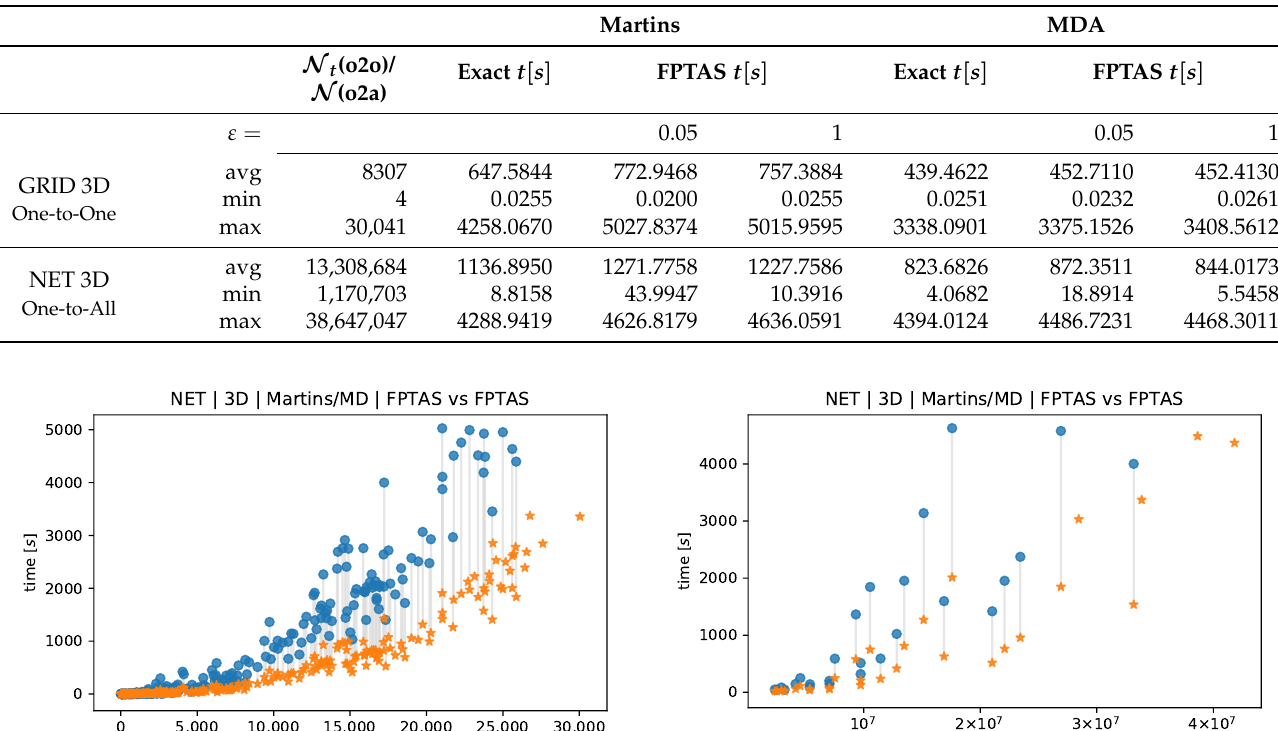
Table 4. Results obtained by 3-dimensional Martins-FPTAS and MD-FPTAS.